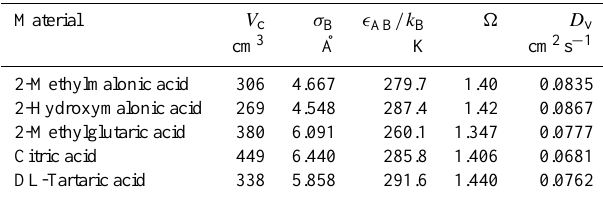
Table 3. Parameters for estimation of organic compound vapor dif- fusivity in N 2 at 600 torr ( ∼ 80kPa) at 298.15K.